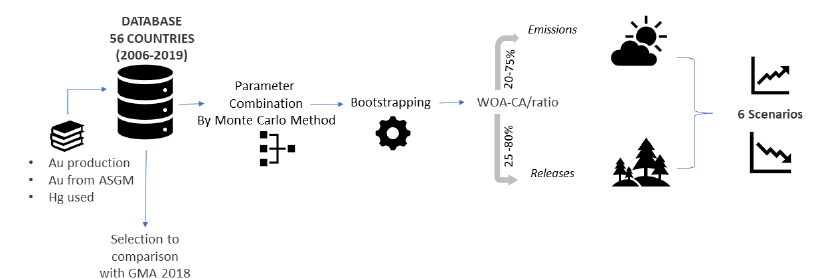
Figure 1. Conceptual workflow of the tasks performed in this study. From an initial database of 56 countries, with more than a decade of observations for the most part of countries, the estimates of Au produced, Hg used, emitted and released were obtained. On the basis of bootstrap method, the emissions and releases of Hg were estimated, then six Hg emissions scenarios were devised, and the corresponding emissions calculated. The comparison with the GMA served also as an out-of-sample evaluation of the